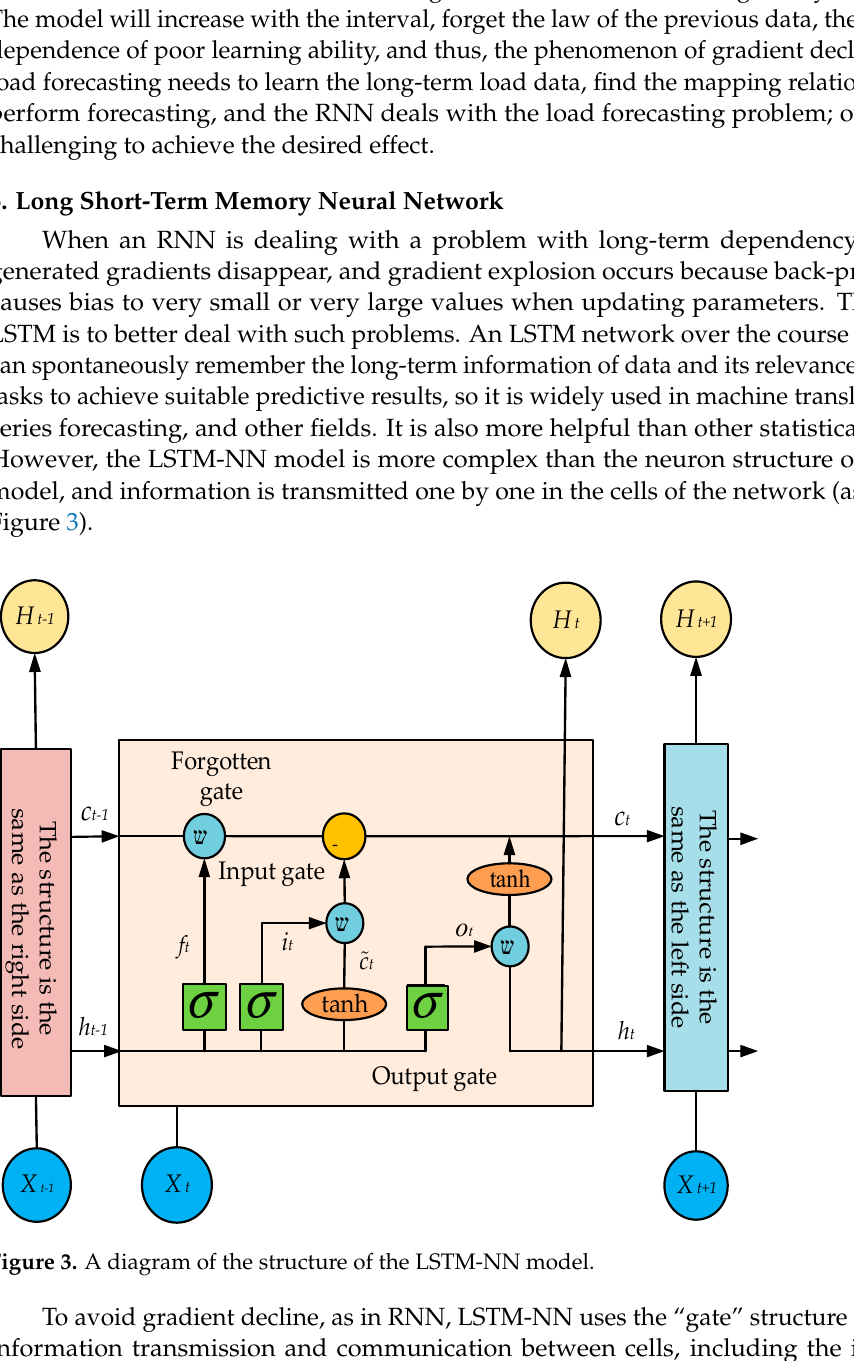
Figure 2. Expanded schematic of the RNN.